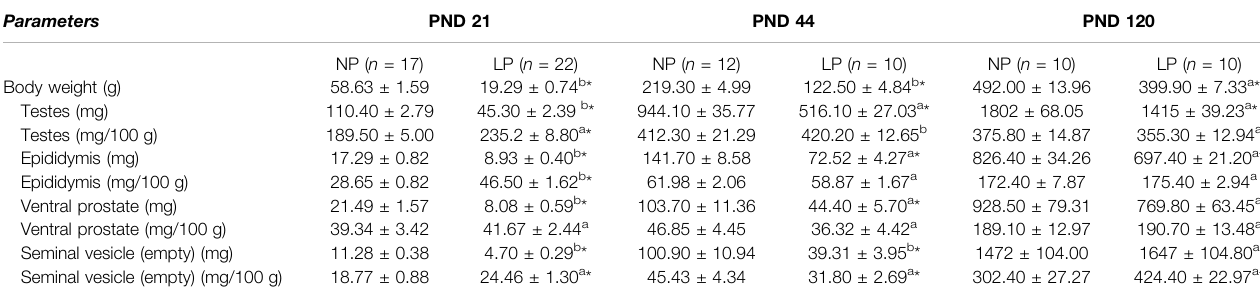
TABLE 3 | Body weight and absolute and relative genital organs weight at PND day 21, 44 and 120. PND 21: NP, n = 17, LP, n = 22; PND 44: NP, n = 12, LP, n = 10; PND 120: NP, n = 10, LP, n = 10. The values are expressed as the mean ± S.E.M. * p < 0.05. Student t-tests was used to analyze the signi fi cance of differences in parametric data ( a ), and Mann-Whitney tests was used to analyze the signi fi cance of differences in nonparametric data ( b ).